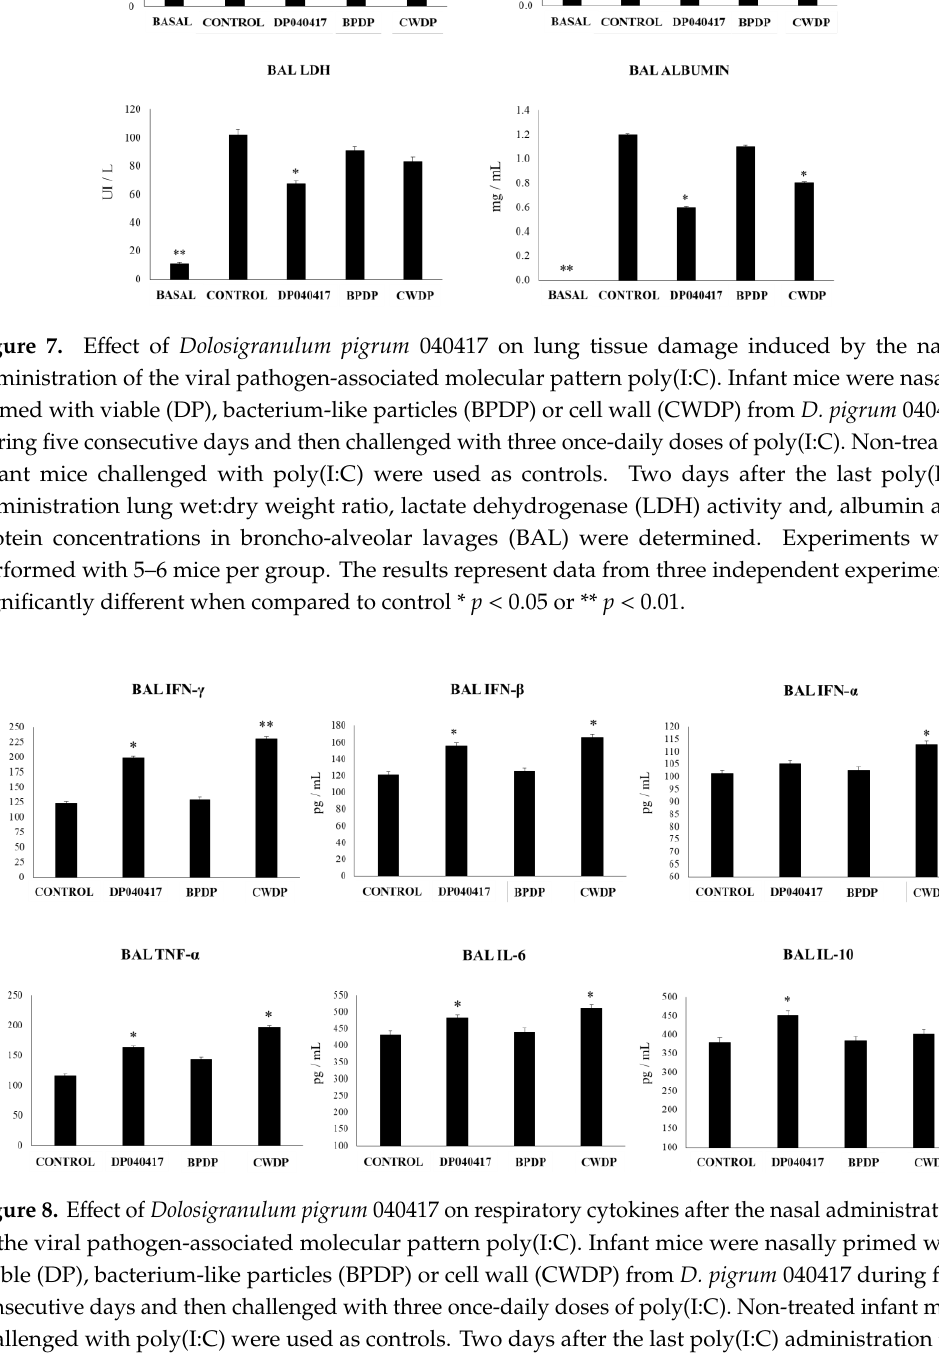
were able to significantly increase the numbers of lung CD11c + CD11b high MHCII + and